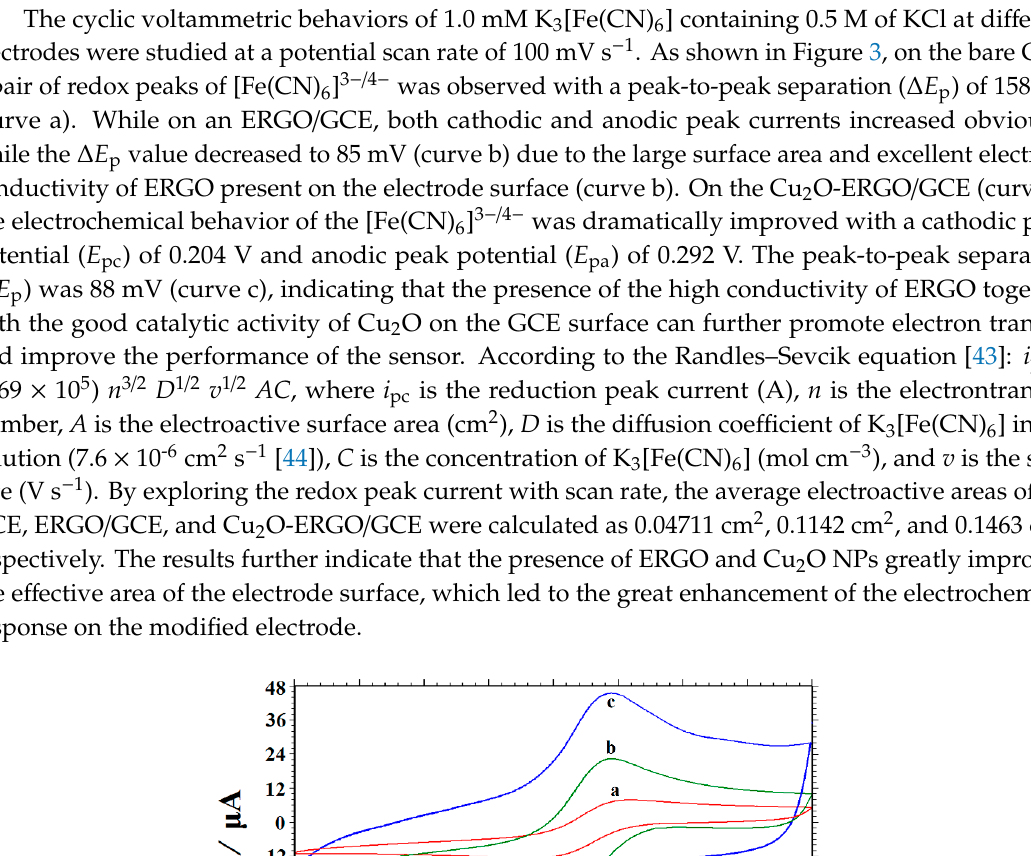
Figure 3. Cyclic voltammograms obtained on ( a ) a glassy carbon electrode (GCE), ( b ) ERGO /